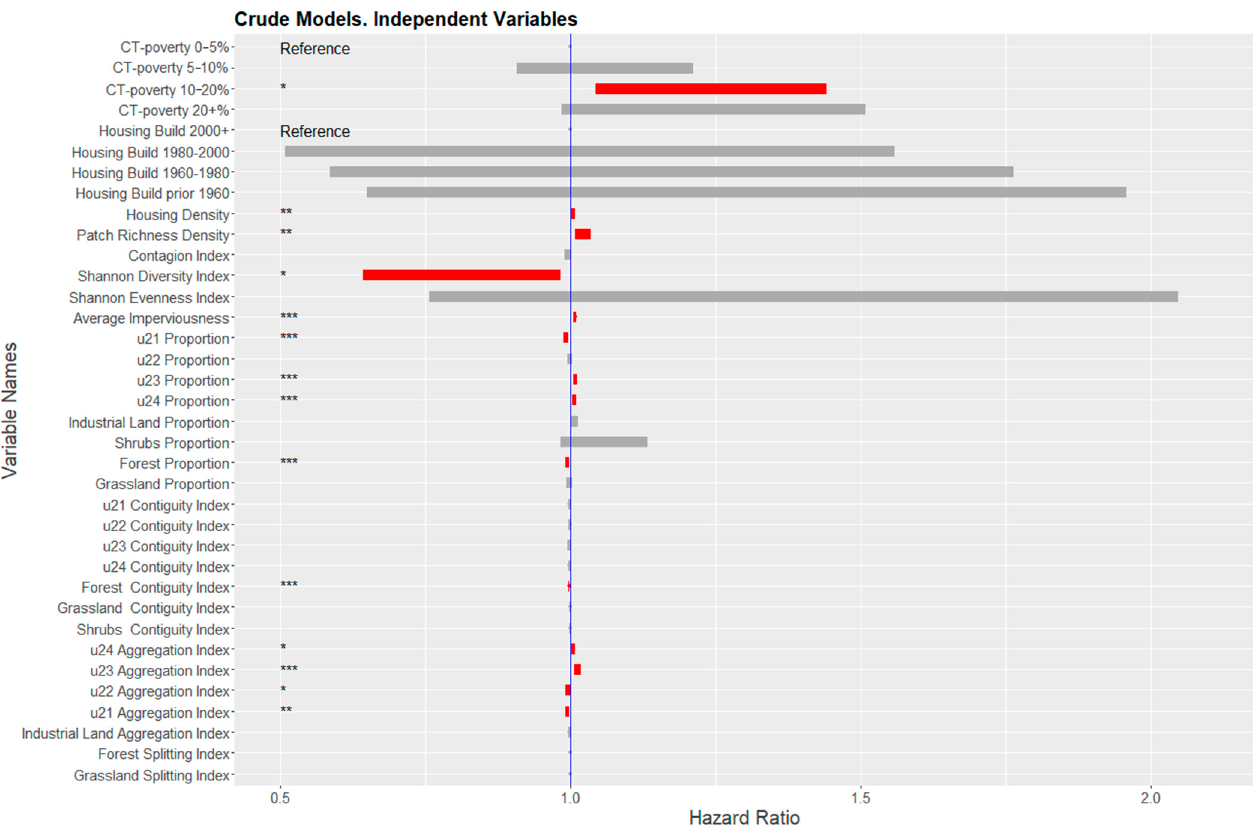
Figure 5. Hazard Ratios of neighborhood-level variables from the crude models, adjusted for each variable individually. Blue line indicates there is no difference in risk. Red bars indicate the 95% confidence interval of statistically significant variables. (Note: Significance levels <0.05 = *; <0.01 = **; <0.001 = *** Land cover classes are based on the reclassified NLCD raster. U21 = Open, U22 = Low, U23 = Medium, U24 = High intensity developed lands).